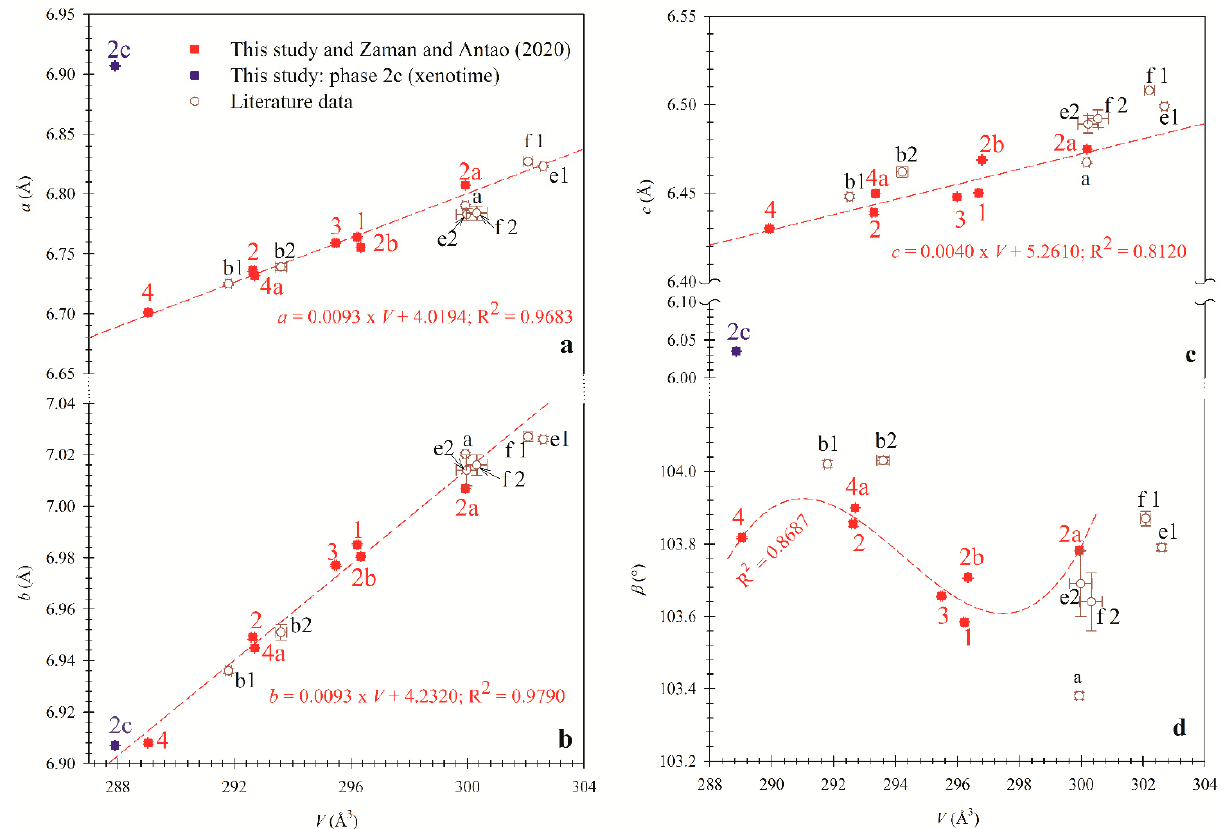
Figure 7. Variations of unit-cell parameters in monazite: ( a ) a vs. V , ( b ) b vs. V , ( c ) c vs. V , and ( d ) β vs. V . The dashed lines represent regression fits for our samples. Phase 2c data is excluded from the fits. Open symbols are data from the literature [a: monazite-(Ce) [11], b1 (SCXRD), and b2 (PXRD) for monazite-(Sm) [54], e1 (phase 1) and e2 (phase 2) for monazite-(Ce) [15], f1 (phase 1) and f2 (phase 2) for monazite-(Ce) [19]]. Some errors are smaller than the symbols. The a , b , and c unit-cell parameters vary with linearity with V , but not with the β angle.